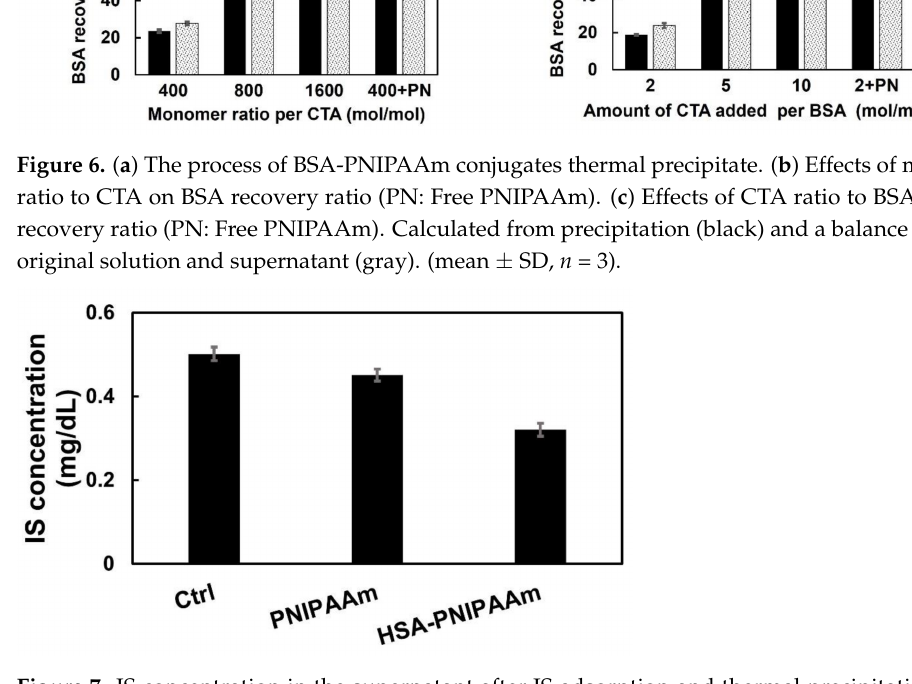
Figure 7. IS concentration in the supernatant after IS adsorption and thermal precipitation using HSA-PNIPAAm conjugate (mean ± SD, n =